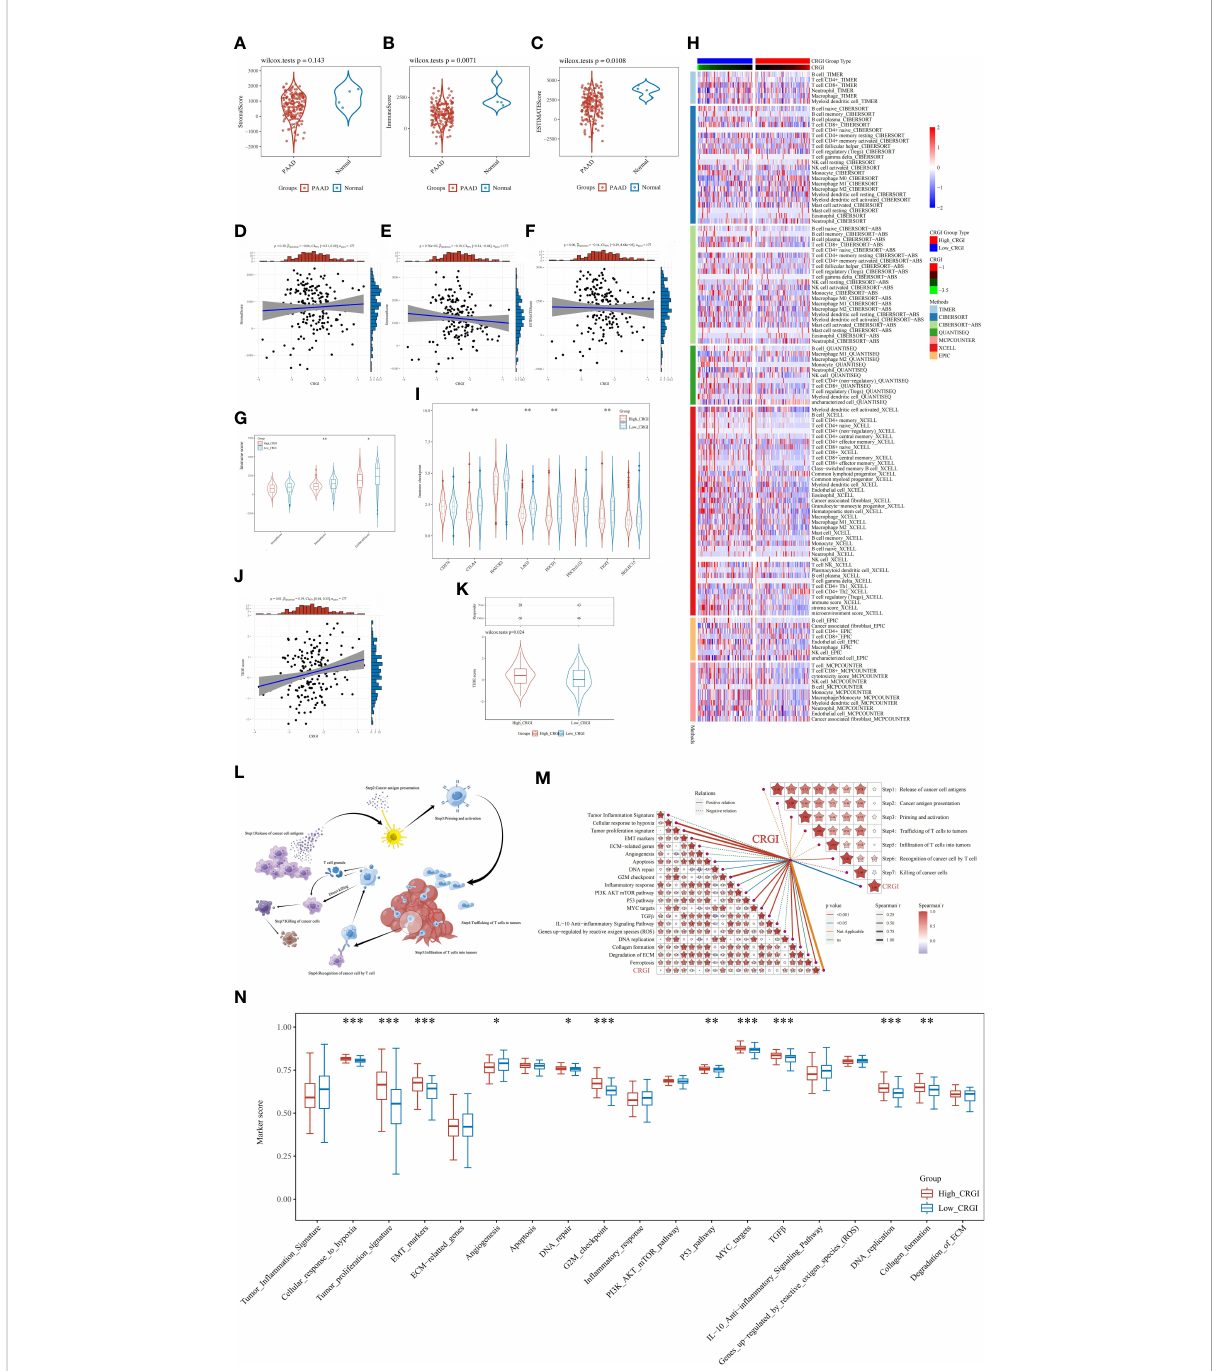
FIGURE 6 In-depth analytics on the relationship between CRGI and the tumor microenvironment condition, immune cell in fi ltration, immunotherapy ef fi cacy, TMB, as well as the cancer-immunity cycle. (A – C) Comparison of the stromal, immune, and ESTIMATE scores of tumorous and normal tissues in the TCGA dataset. (D – F) Correlation analysis between the CRGI and the stromal, immune, and ESTIMATE scores. (G) The violent plot demonstrated the comparison of the stromal, immune, and ESTIMATE scores in the high- and low-CRGI groups. (H) The heatmap demonstrated the diverse immune cell types in the in fi ltration process. (I) The violent plot demonstrated the comparison of the expression of the representative genes of the soundest immune checkpoints in the high- and low-CRGI groups. (J) Correlation analysis between the TIDE score and CRGI. (K) The violent plot demonstrated the comparison of the TIDE scores in the high- and low-CRGI groups. (L) Graphical demonstration of the cancer-immunity cycle. (M) Correlation analysis between the CRGI and the main steps of the cancer-immunity cycle as well as the 19 known biological processes. (N) The boxplot demonstrated the comparison of marker scores in the high- and low-CRGI groups. *, **, ***, and **** indicate the P-value thresholds 0.05, 0.01, 0.001, and 0.0001,